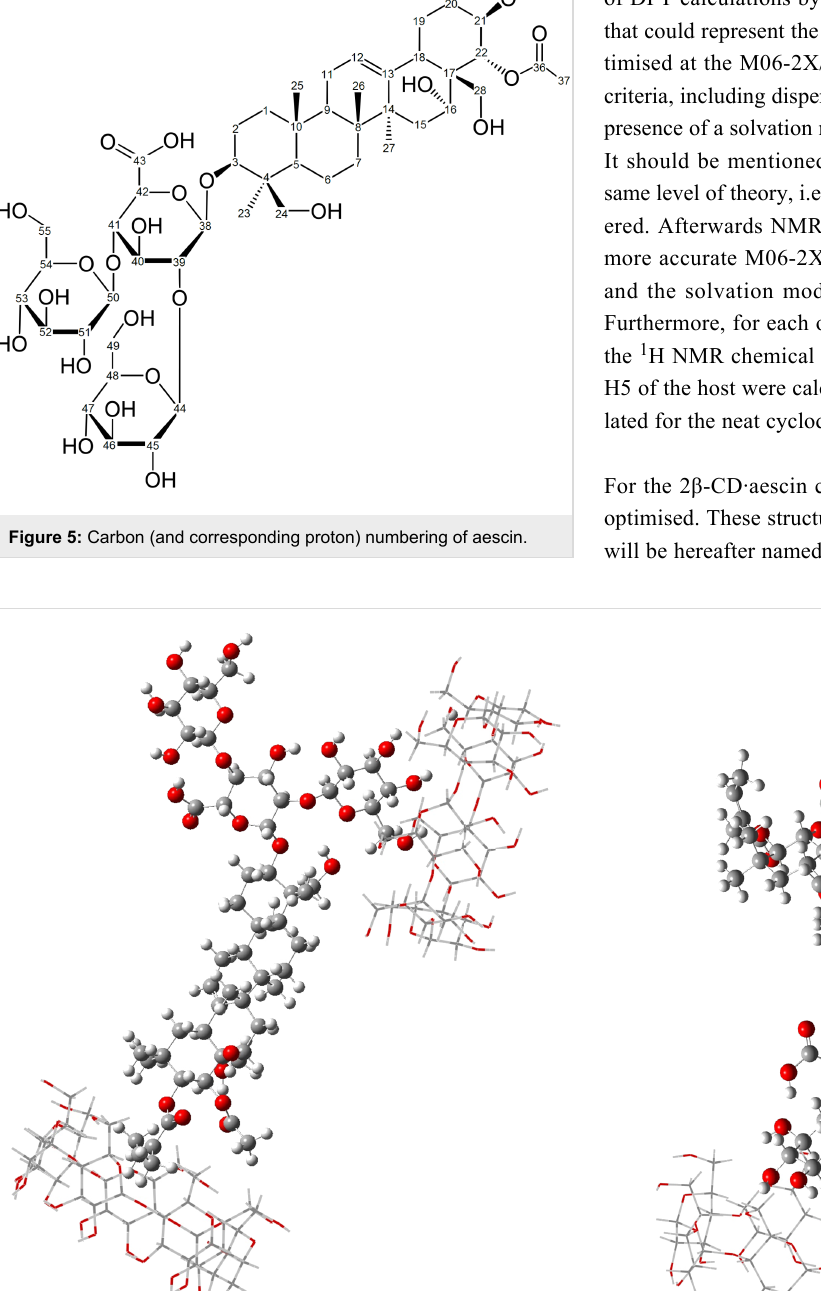
Figure 6: Optimised structures of the theoretical 2 β -CD·aescin complex β 1 (a) and complex β 2 (b).